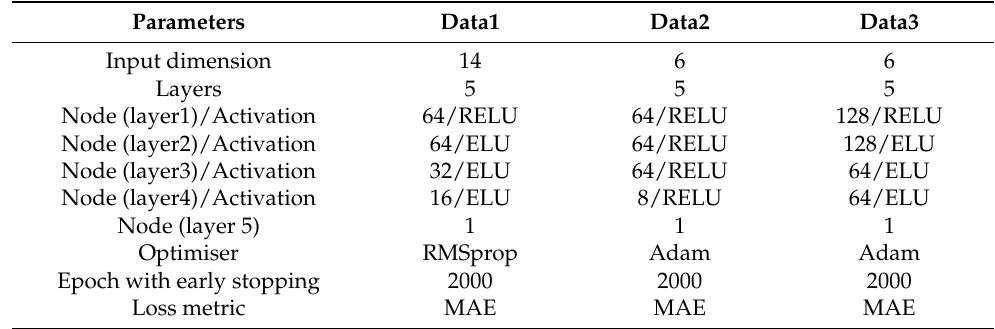
Table 5. Number of selected parameters in each